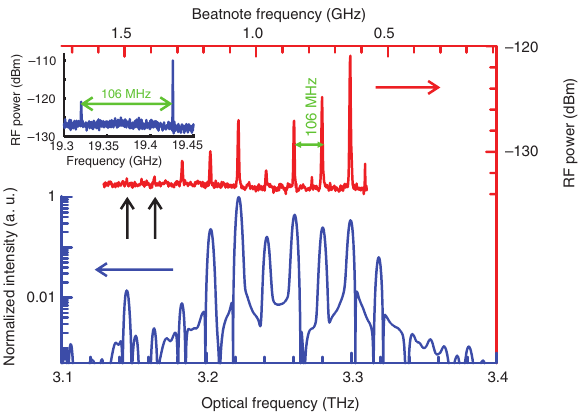
Figure 3: Dual-comb experiment: FTIR (Bruker 80v) measurement of two lasers operating as FCs (blue curve). The two lasers are both 2 mm × 60 μ m. Laser 1 is driven at 595 mA and laser 2 at 550 mA. The temperature is fixed to 26 K. Only a single set of modes is observed as the offset between the two sets of laser modes is below the resolution limit of the FTIR (2.25 GHz). The red curve is the corre- sponding multiheterodyne spectrum recorded with an RF spectrum analyzer (Rohde & Schwarz FSU50; RBW: 2 kHz, VBW: 20 kHz, SWT: 250 s). The signal was extracted with a bias-tee from the bias line of one of the two lasers. The two black arrows indicate the positions of the two weakest modes of the multiheterodyne spectrum. The RF signal is truncated below 0.6 GHz due to strong pickup noise in the experimental setup. The inset shows the two intermode beatnotes of the two lasers (RBW: 10 kHz, VBW: 100 kHz, SWT: 2